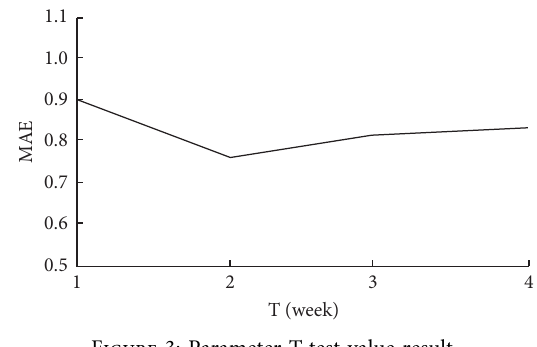
Figure 3: Parameter T test value result.